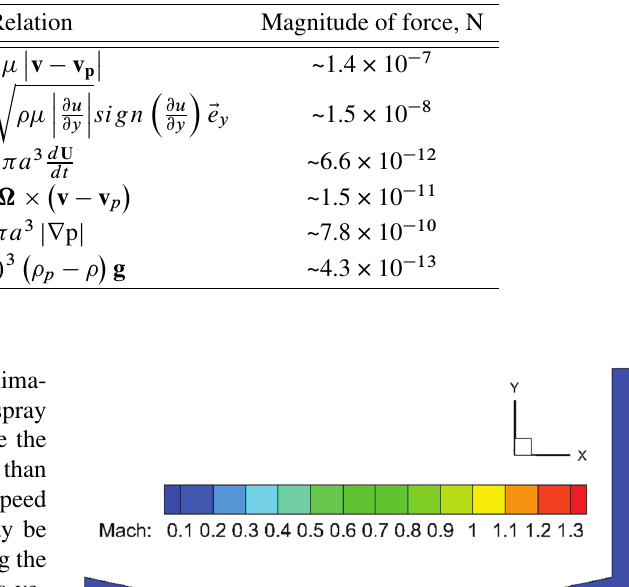
Table 2. Approximate magnitude of forces acting on aerosol particles [24].